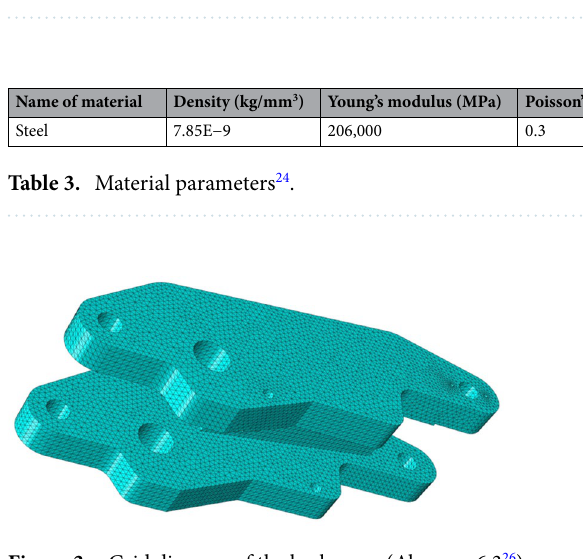
Table 2. Kinematic joints.